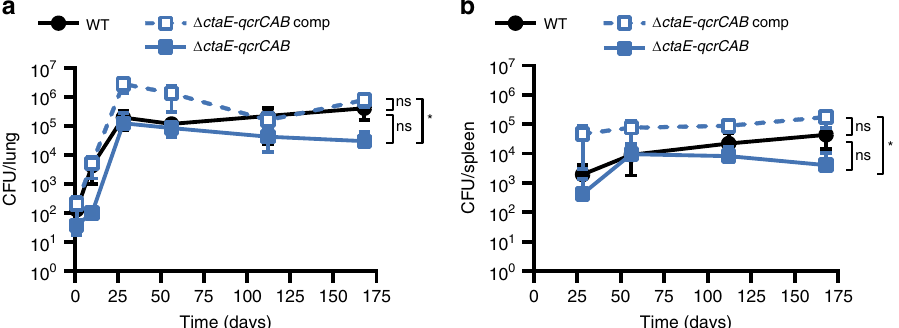
Fig. 1 The cytochrome bc1-aa3 complex is dispensable for growth and persistence of Mtb in mice. Growth and persistence of Δ ctaE-qcrCAB in mouse lungs ( a ) and spleens ( b ). Data are averages of CFUs from at least three mice per time point. Error bars correspond to standard deviation. “ Comp ” stands for complemented. Statistical signi fi cance was assessed by one-way ANOVA followed by post hoc test (Tukey test; GraphPad Prism). * P < 0.05; ns - not signi fi cant. Source data are provided as a Source Data fi